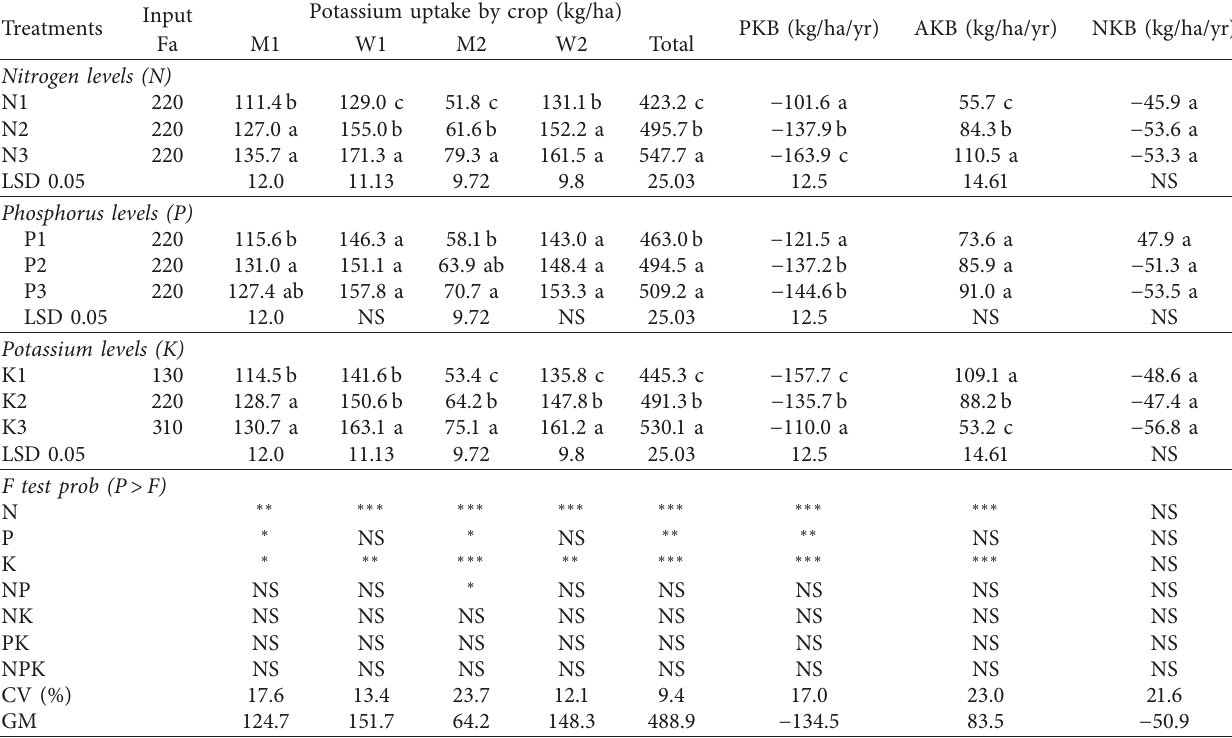
Table 5: Partial balance, apparent gain or loss, and net gain or loss of potassium (kg/ha) per year as affected by fertilization in the maize- wheat experiment, Khumaltar, Lalitpur, 2019/20–2020/21.